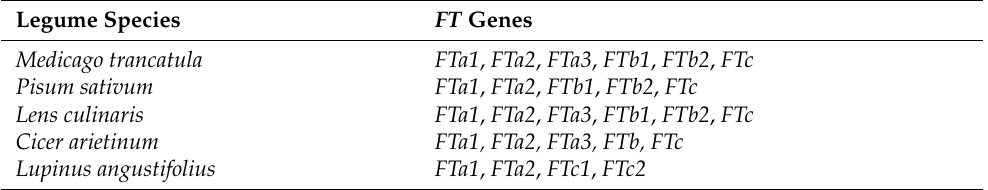
Table 1. The orthologs of Arabidopsis FLOWERING LOCUS T (FT) gene in legumes. Legume Species